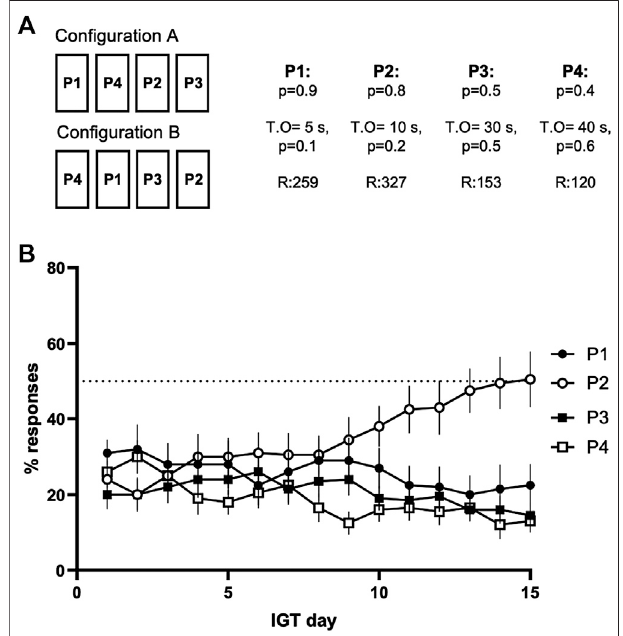
FIGURE 2 | (A) The four active panels had unique reward-punishment contingencies, and the two different con fi gurations, A and B, were used in different chambers. The panels are named after the number of sucrose rewards each of the panels gave. The fi rst p-number indicates the probability of the reward. The punishments were given as time-out periods, the probability and the length of the time-out rising together with the reward (T.O for the time-out in seconds, p for the probability of the punishment). The R-numbers indicate themaximumnumber ofreinforcementsofeach panel ifit was chosen exclusively during the session (B) The development of option selectionduringthe fi rst15 daysoftheIowaGamblingTaskphase,priortothe drug treatment sessions. Data shown as mean ±